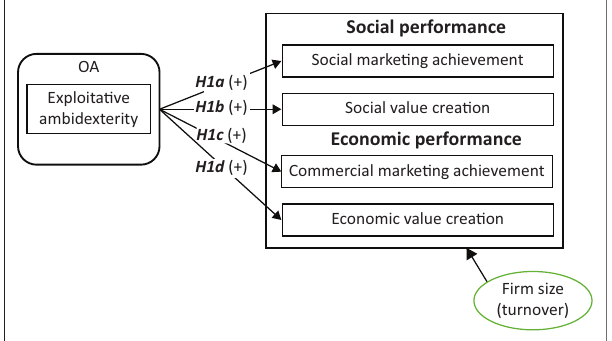
FIGURE 1: Conceptual model of the exploitative ambidexterity – social enterprise performance relationship.